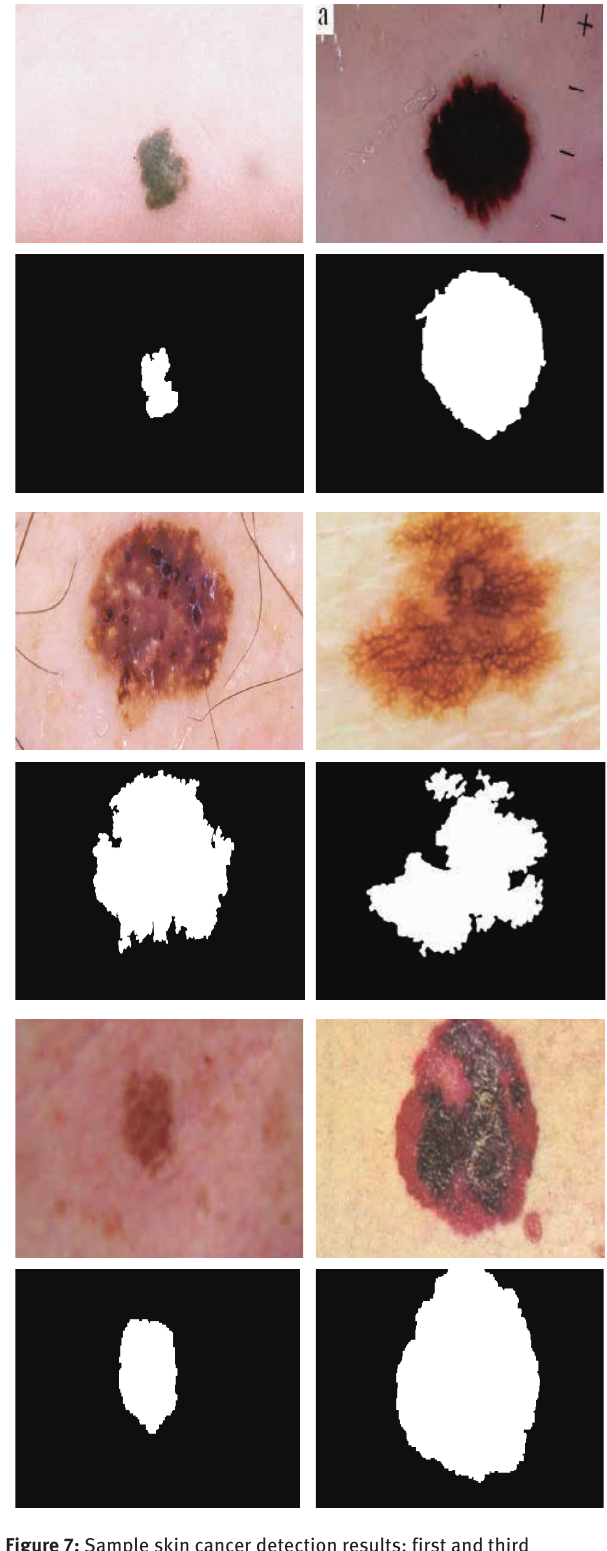
Figure 7: Sample skin cancer detection results: first and third columns: input images, second and fourth column: detected masks based on optimized CNN/WOA